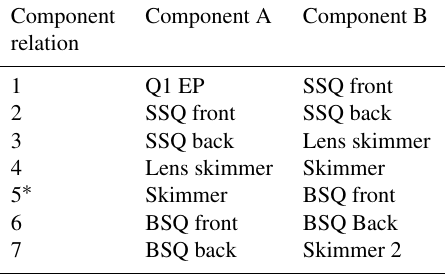
Table 1. Component relationships defined by adjacent components in the API (see Fig. 1 for API